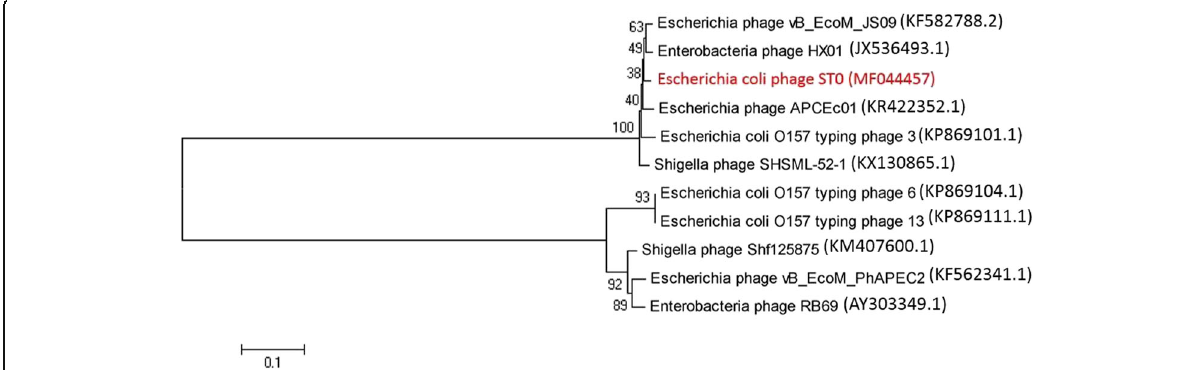
Fig. 2 Neighbor-joining phylogenetic tree based on the complete genome sequence of phage